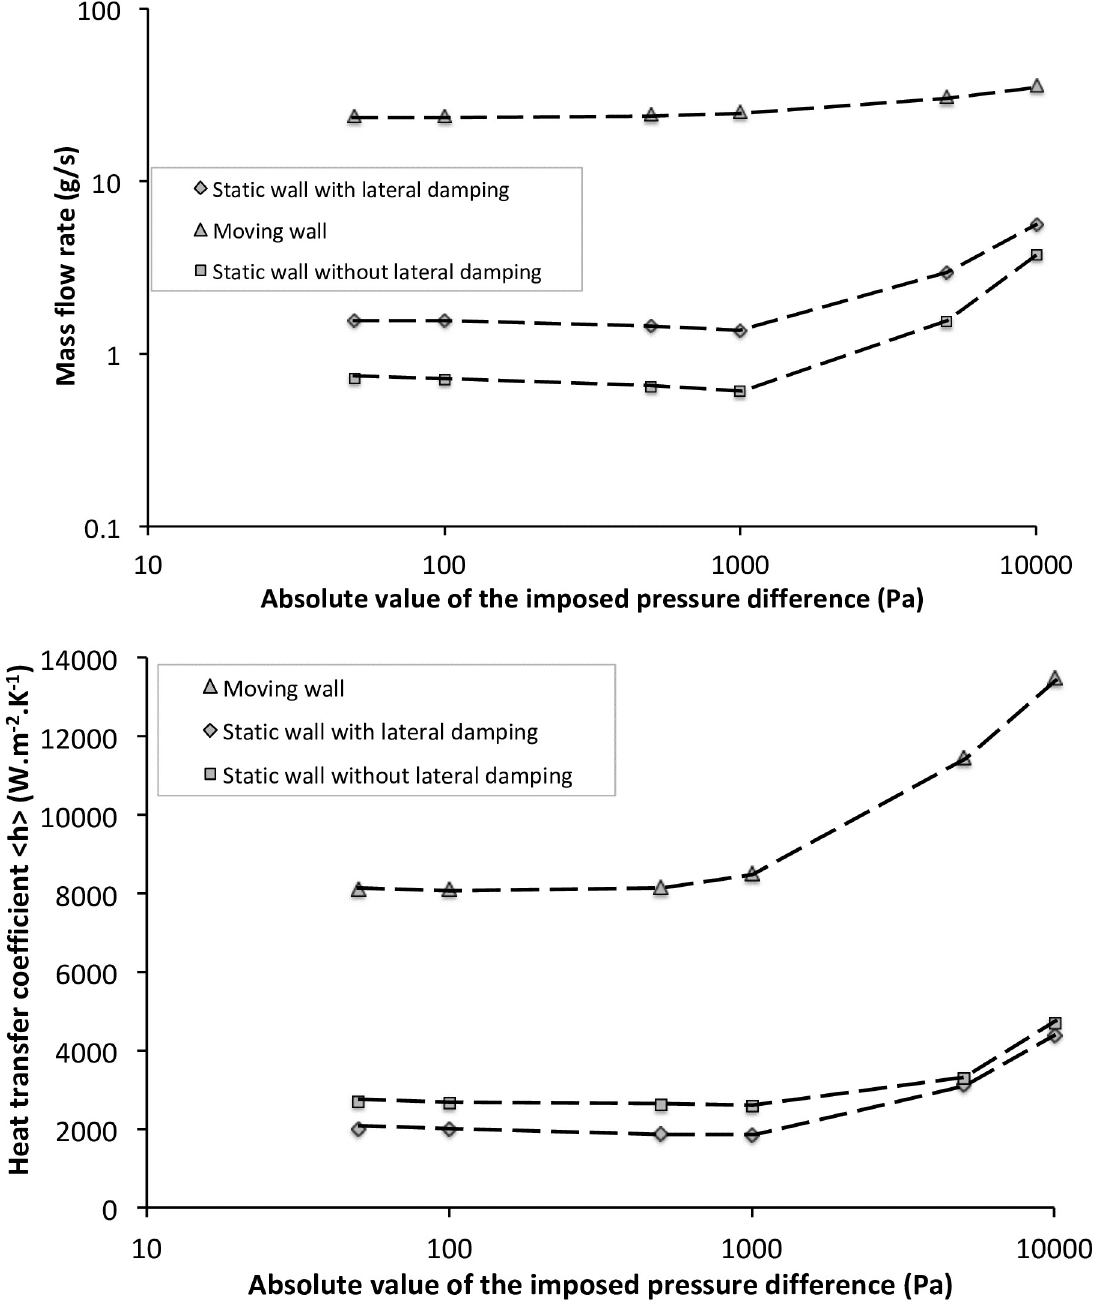
Fig 9. Performances of the dynamic corrugated heat exchanger. (a) Mass flow rate and (b) Heat transfer coefficient for corrugated moving, static with and without lateral damping (log-log scales). Different imposed negative pressure differences for relative amplitude of A = 89% and f r = 50 Hz